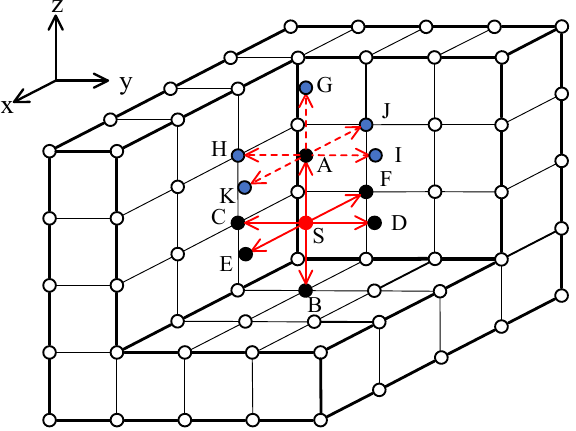
Figure 2. Three-dimensional FMM calculation example.